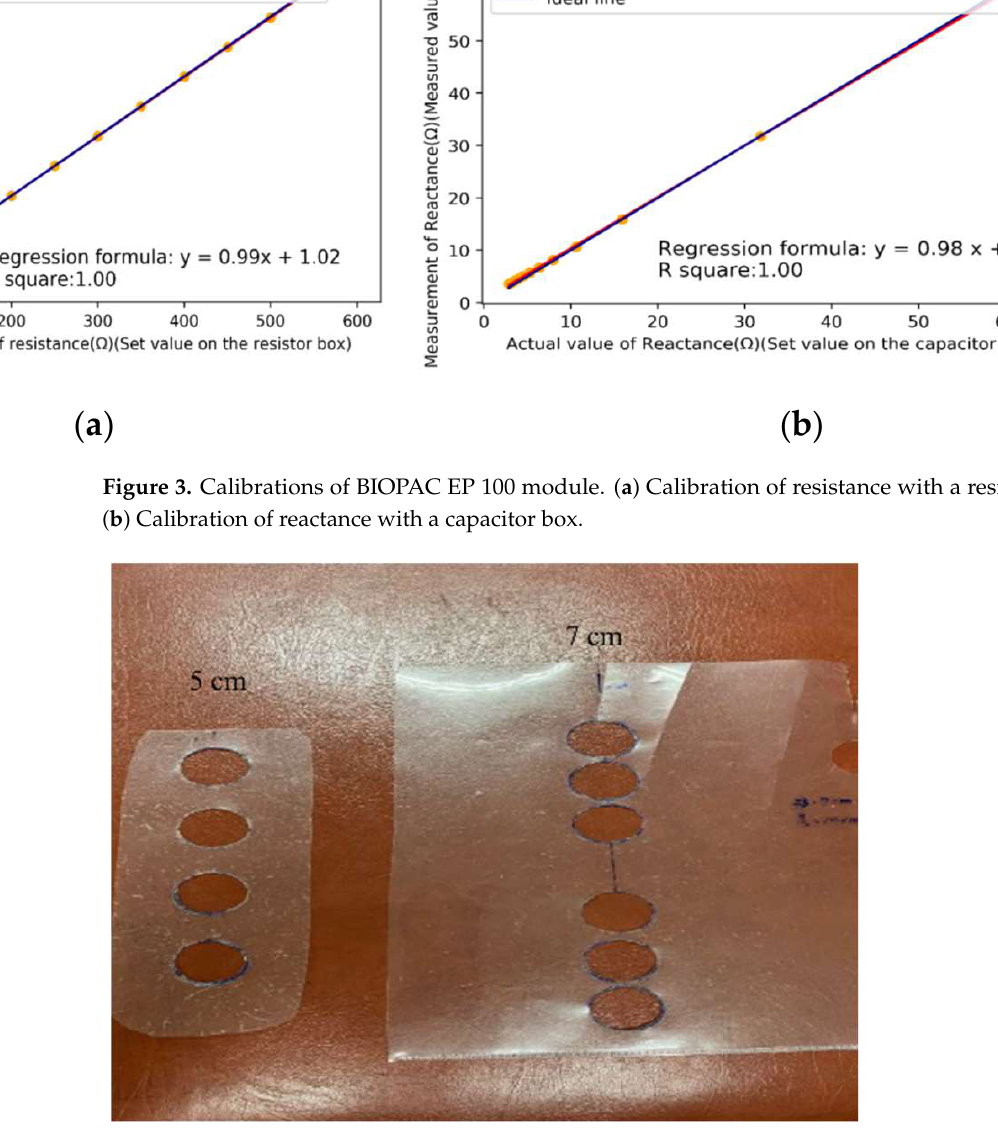
Figure 4. Placement of four electrodes with two schemes, 5 cm and 7 cm. Table 1. The information of